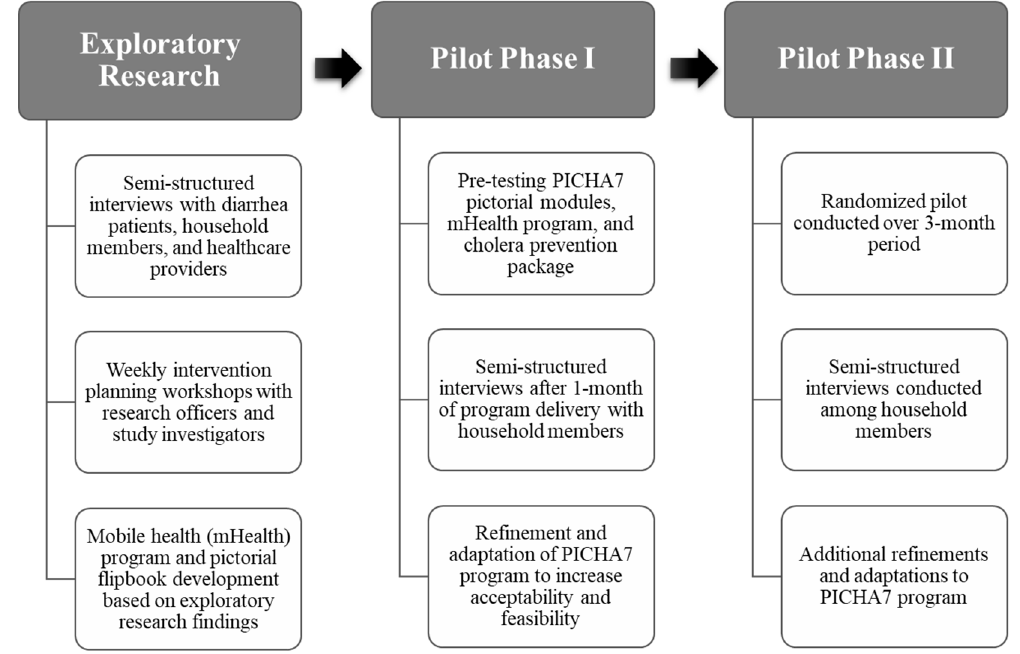
Figure 1. Overview of PICHA7 formative research activities. Table 1. Demographic characteristics of interviewees.